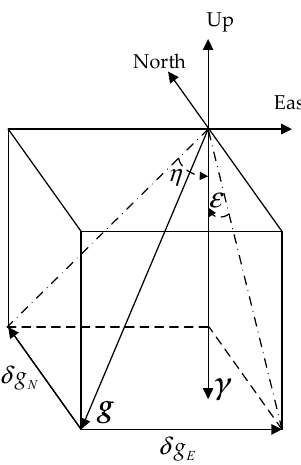
Figure 2. The definition of deflection of vertical and horizontal gravity disturbance.